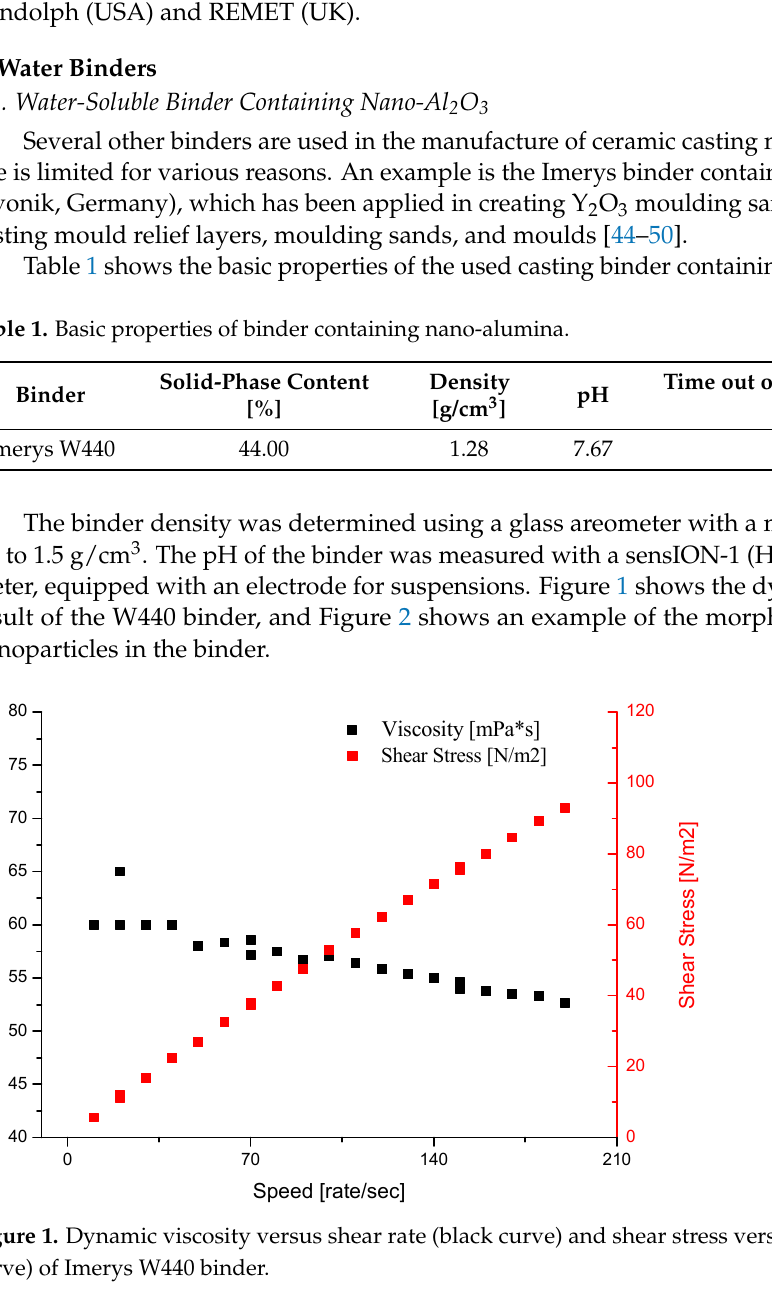
Figure 2. Morphology of Al 2 O 3 nanoparticles in Imeris W440 polymer binder. Figure 3 shows an example of a SiC mould in its raw state (after the 3rd layer was applied) obtained using the Imerys W440 binder. The suitability of this binder for obtaining actual silicon carbide casting moulds was confirmed. Figure 3. Example SiC mould (raw state) obtained using Imerys W440 binder.